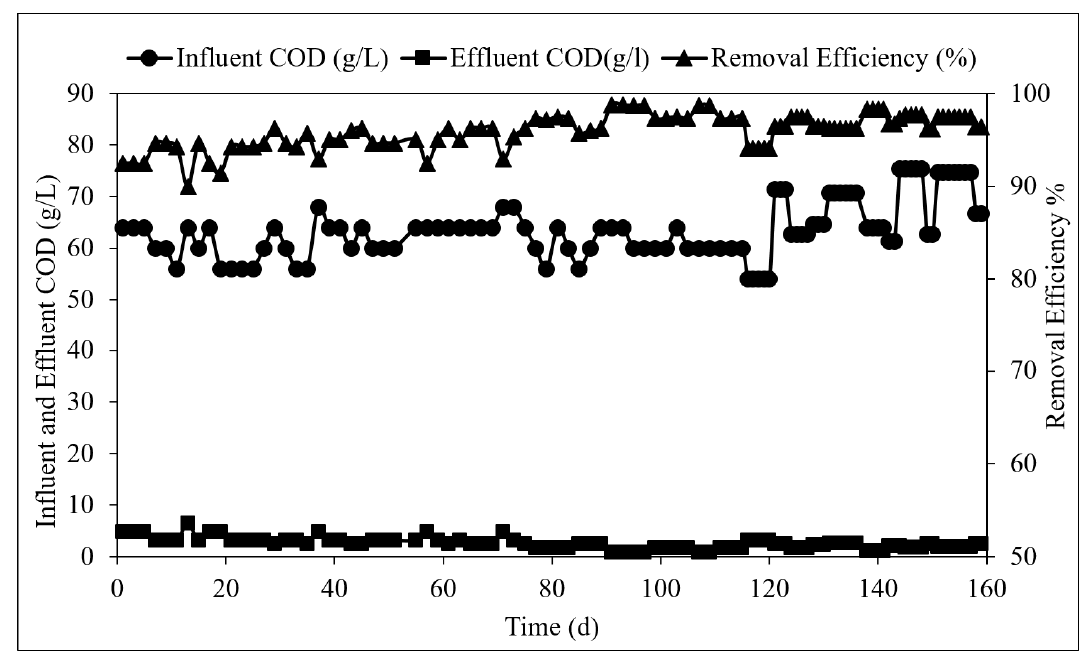
Figure 5. Influent and effluent COD concentrations and removal efficiency during the TAnMBR operation.